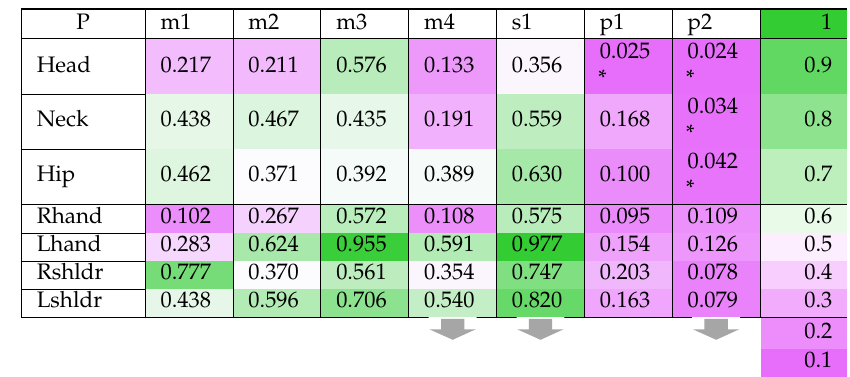
Table 2. The di ff erence probabilities between Day 1 and Day 2 in the plots of MMSE versus body joint motion by MANOVA. Note * indicates statistical significance ( p < 0.05).